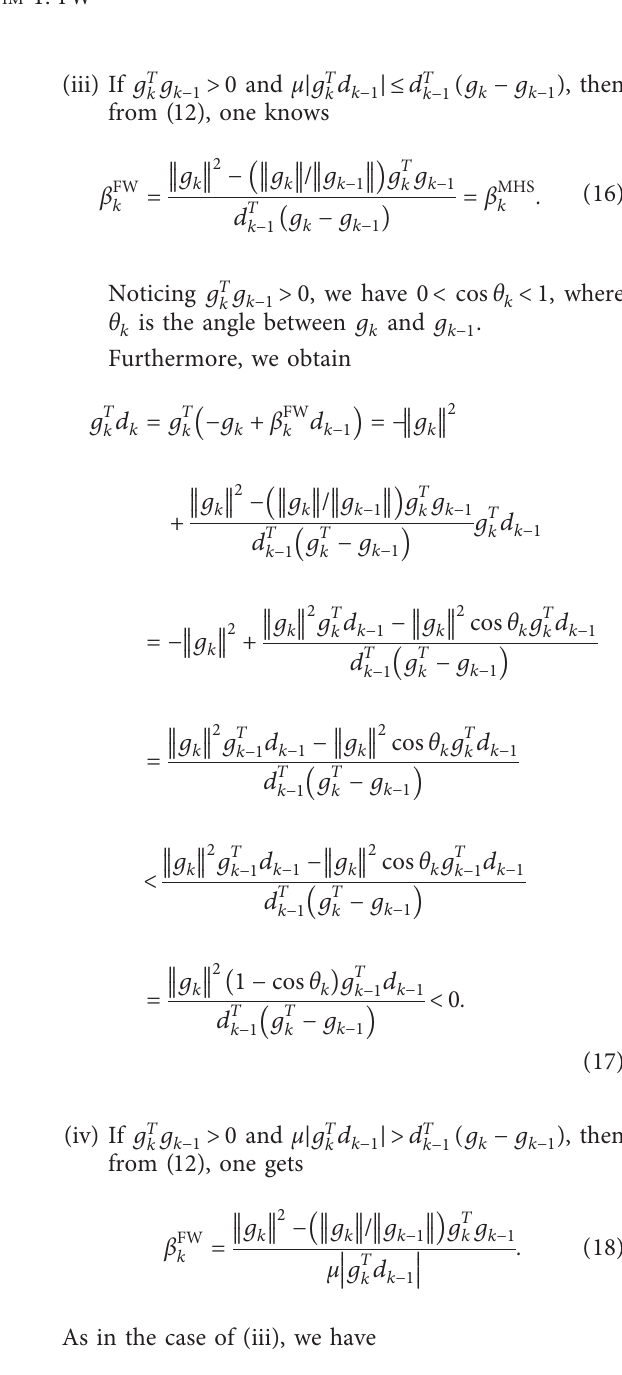
Algorithm 1 is always sufficient descent depending on